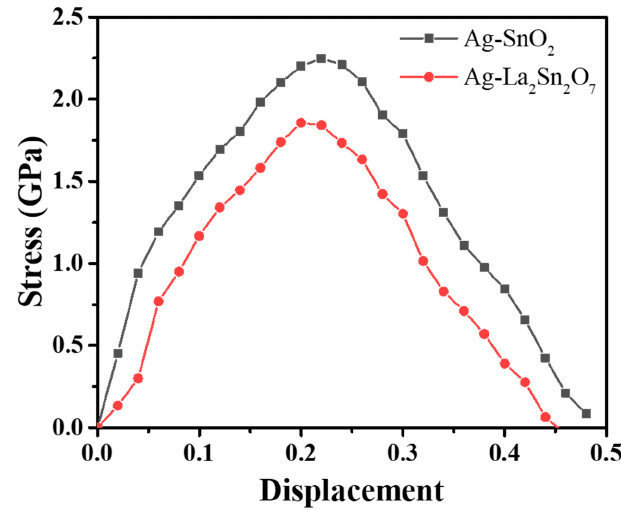
Figure 7. Stress–displacement curves at the Ag − SnO 2 interface and Ag − La 2 Sn 2 O 7 interface.